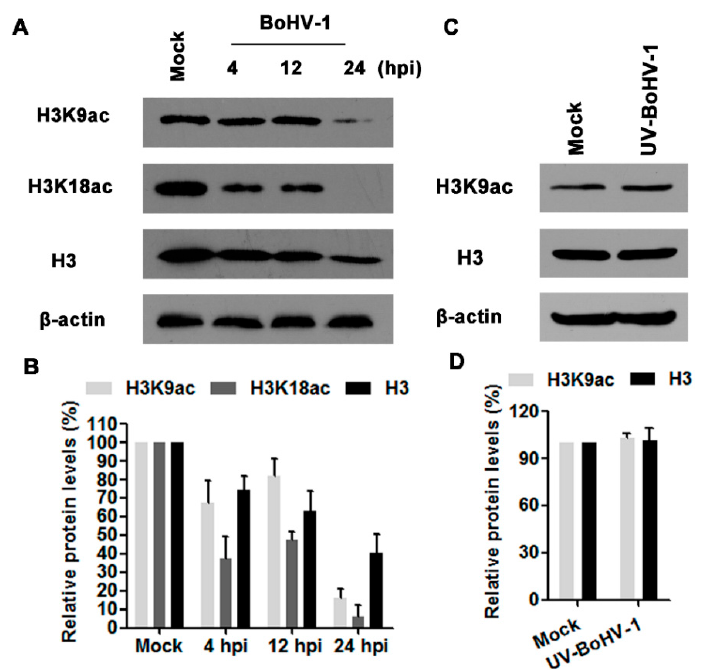
Figure 1. The effects of BoHV-1 infection on histone H3 acetylation. ( A ) MDBK (Madin-Darby bovine kidney) cells in 60 mm dishes were mock infected or infected with BoHV-1 at a MOI of 1 for 4, 12 and 24 h. The cell lysates were then prepared for Western blots to detect histone H3, H3K9ac and H3K18ac. Data shown are representative of three independent experiments. ( C ) MDBK cells in 60 mm dishes were mock infected or infected with UV (ultraviolet)-inactivated BoHV-1 at an MOI of 1 for 24 h. The cell lysates were prepared and subjected to Western blots to detect histone H3 and H3K9ac. Data shown are representative of three independent experiments. ( B , D ) The band intensity was analyzed with software image J. Each analysis was compared with that of uninfected control which was arbitrarily set as 100%. The error bars denote the variability between the three independent experiments.